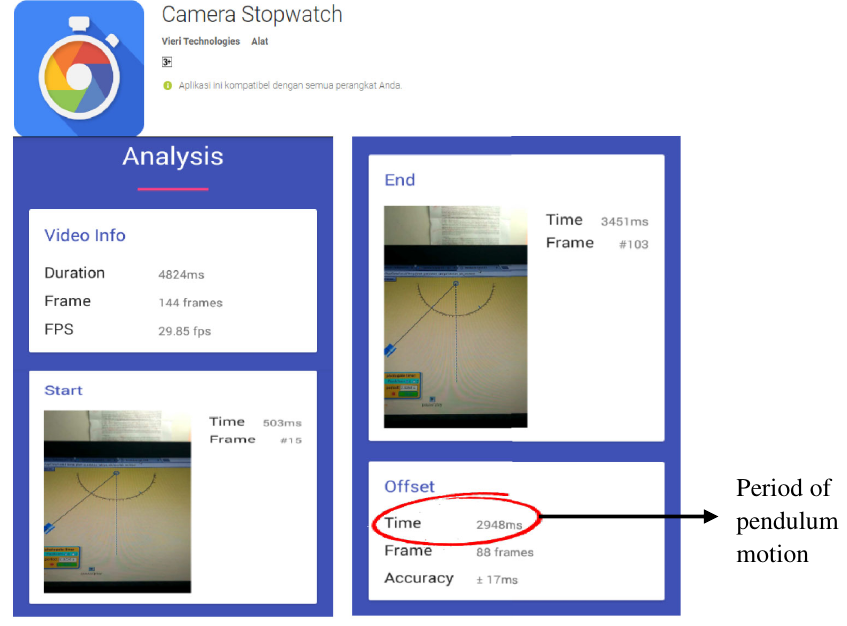
FIG. 4. Camera stopwatch